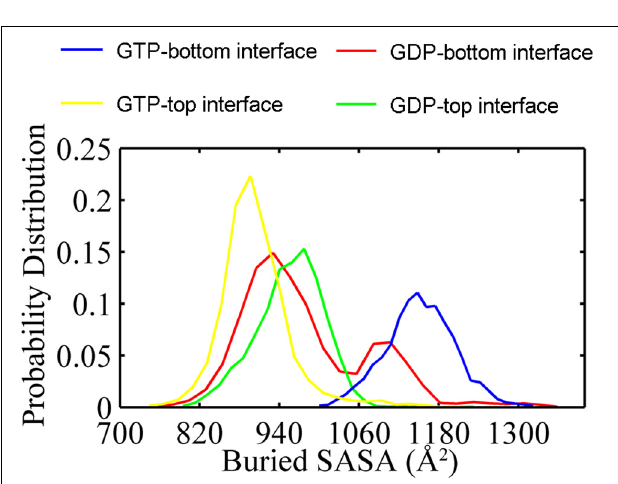
FIGURE 3 | Distribution of buried SASA values for the GTP- (yellow) and the GDP-bound (green) top interfaces, and for the GTP- (blue) and the GDP-bound (red) bottom interfaces. The interfaces start from the same value about 1200 Å 2 . In all the cases, the buried SASAs are calculated by averaging all the GTP-bound (two runs) or GDP-bound (three runs) trajectories.